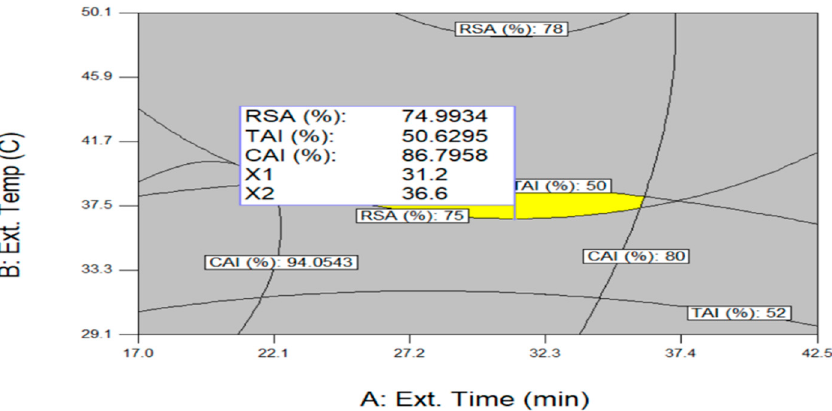
Figure 5. Superimposing contour map for simultaneous optimization of three variables for the maximization of RSA (%), TAI (%), and CAI (%). Ethanol concentration was fixed at the optimum level of 93.2%. Table 5. Comparison of RSA, TAI, and CAI of peanut shell extract obtained by Soxhlet extraction (SE) and ultrasound-assisted extraction (UAE) at different extraction